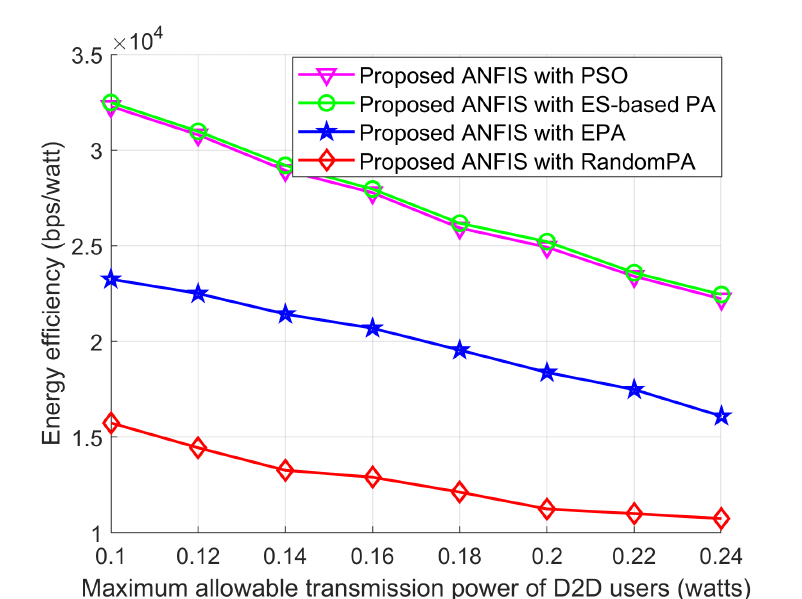
Figure 15. EE performance with P Max